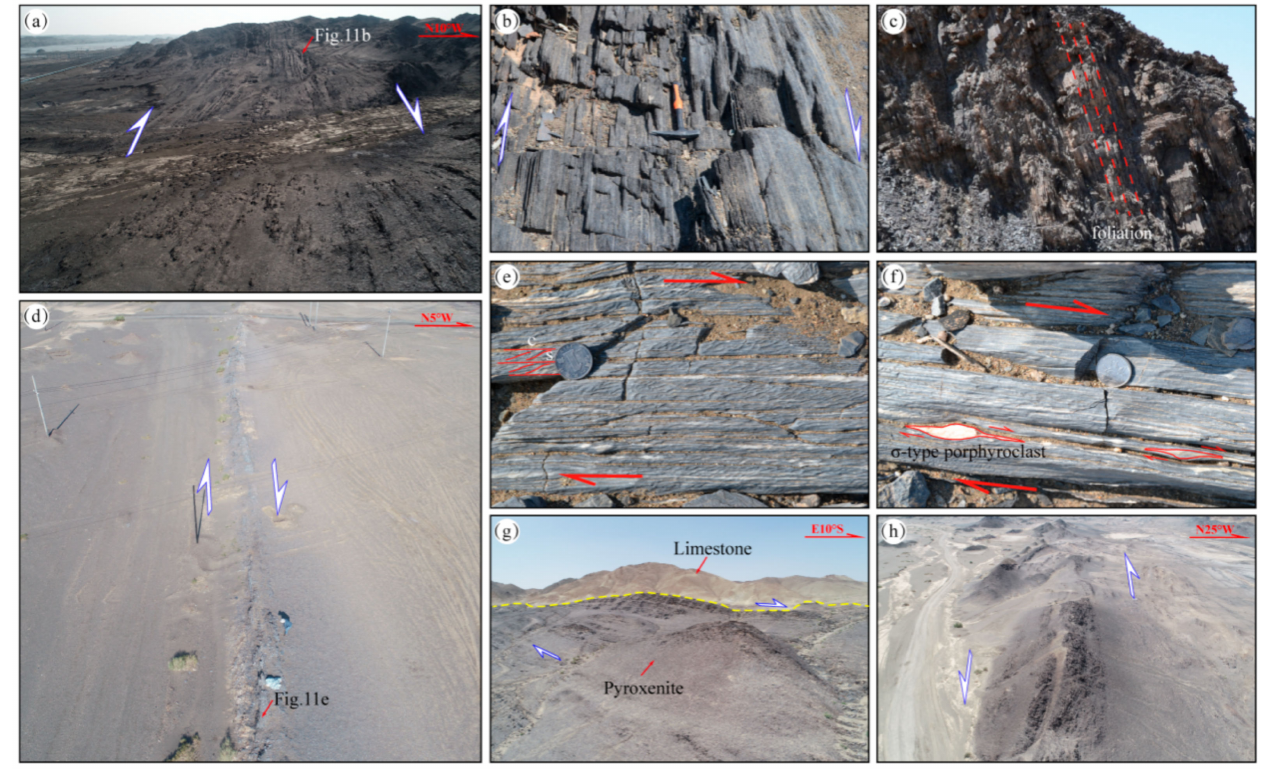
Figure 13. UAV images and detailed photographs of Huangshan shear zone and strike-slip faults in the field. UAV image and photograph ( a , b ) show regional dextral strike-slip shearing in the site of SZ1. A photograph at the site of SZ2 ( c ) shows a foliation structure with SSE-dipping. UAV images ( d , g ) and photographs ( e , f ) show spatial geometry and structural features in the site of SZ4 and surroundings. A UAV image ( h ) also shows a secondary left-lateral shearing fault in the site of SZ3. The location of all observation sites is shown in Figure